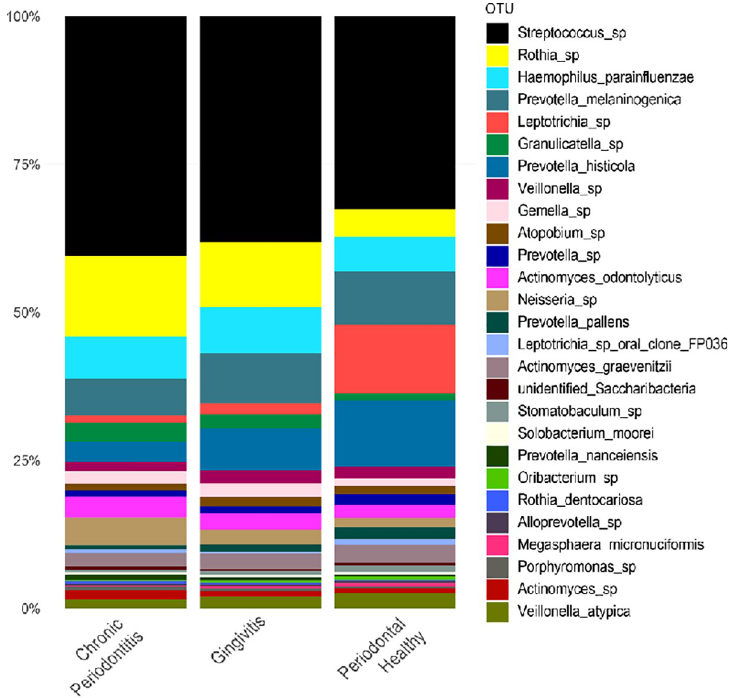
Fig 2. Relative proportion of oral bacteria in healthy and diseased samples. Relative proportion refers to the percentage of each genus/species (indicated by different colors) in a patient group. Overall, 22 samples were analyzed being 4 (18.2%) retrieved from healthy patients, 12 (54.5%) from those with gingivitis, and 6 (27.3%) from those with chronic